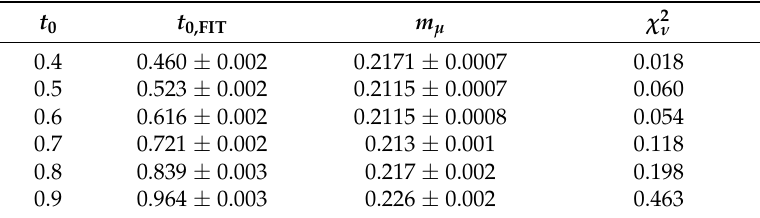
Table 1. Values of the fitting parameters t 0,FIT and m µ of the noise reduction factor as a function of σ 0 for (cid:104) m (cid:105) = 2.23 and η = 0.145 in the case of Gaussian distributions of t . In the last column the χ 2 per degree of freedom is shown.